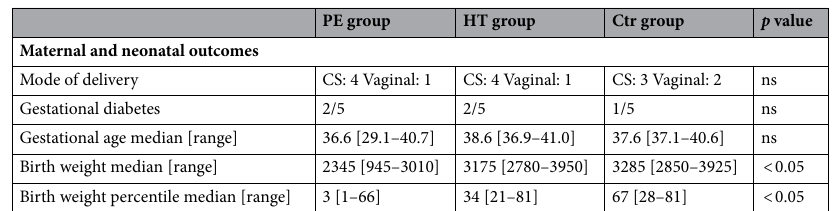
Table 2. Perinatal outcomes (n = 5 for each group) . CS caesarean section, Ctr control, HT hypertension, PE Preeclampsia.